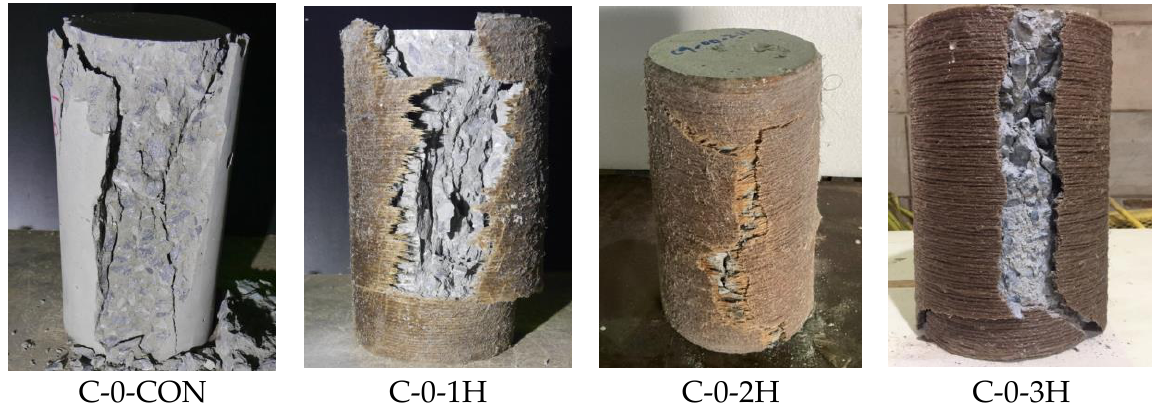
Figure 5. Failure modes of concrete prisms (Group 1).